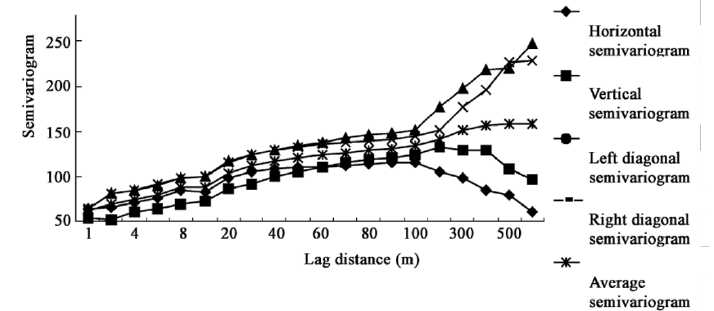
Fig. 6 Semivariance of urban landscape experiment